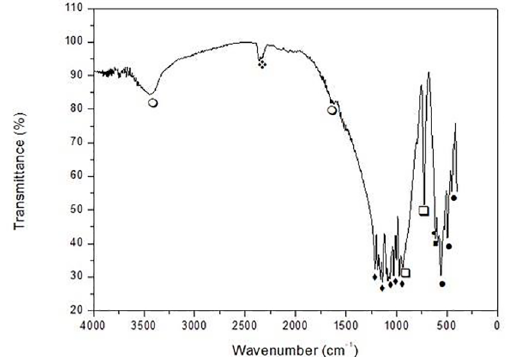
Figure 6. FTIR spectrum of the calcium phosphate powder: mH vCO ; wPO 3-2 ; qCO 2